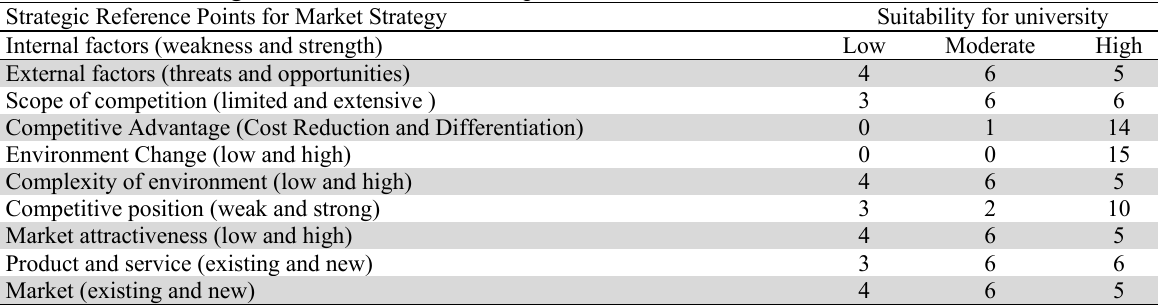
Average of experts' opinions Strategic Reference Points for Market Strategy